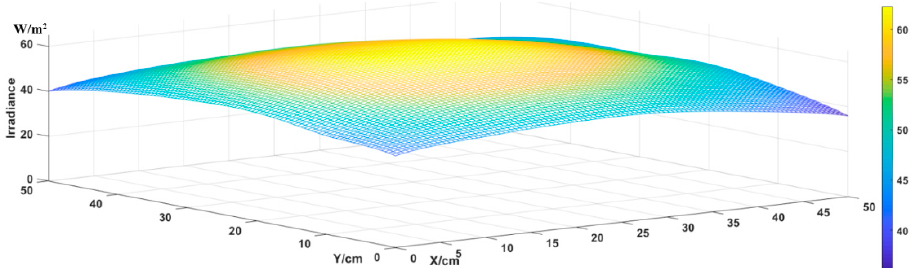
Figure 10. Radiation illuminance distribution diagram of the irradiation plane.